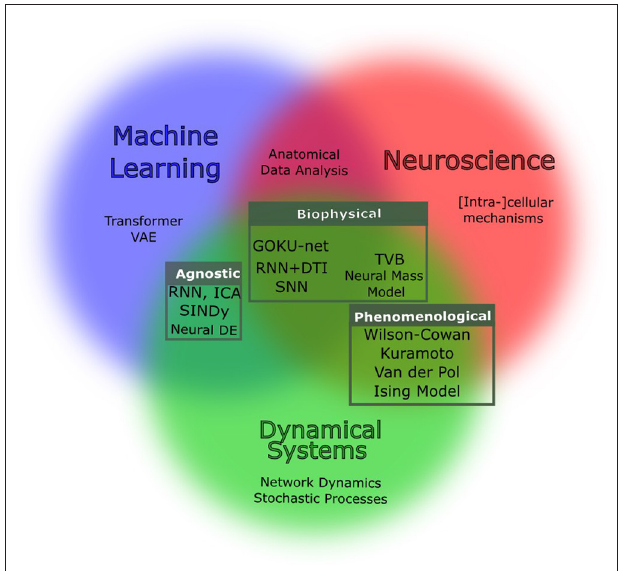
FIGURE 1 | Venn diagram of the generative models of interest. Based on the abstraction and assumption, methods might belong to one or more of the three worlds of machine learning, neuroscience, and dynamical systems. This review is structured into three main categories that are in fact, intersections of these fields: biophysical (Section 1), phenomenological (Section 2), and agnostic modeling (Section 3). Tools developed independently in each of these fields can be combined to overcome the limitation of